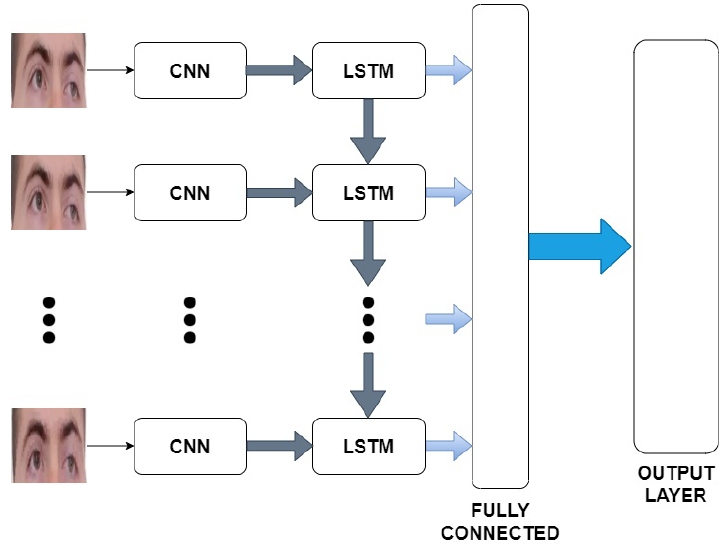
Figure 5. The neural network